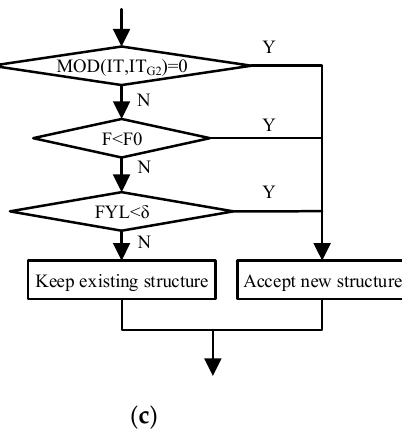
Figure 10. ( a ) Flowchart of the weighted evolutionary strategy. ( b ) Random walk evolution for each individual in the population. ( c ) Individual selection.